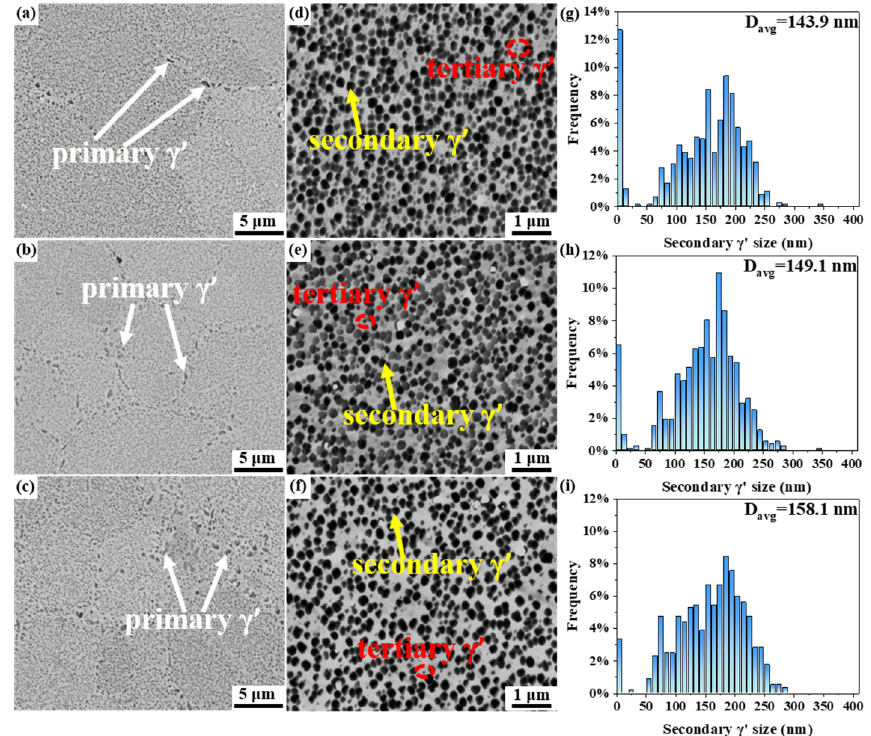
Figure 7. Morphology and distribution of γ ’ in RR1000 with di ff erent scandium addition. ( a , d , g ) 0